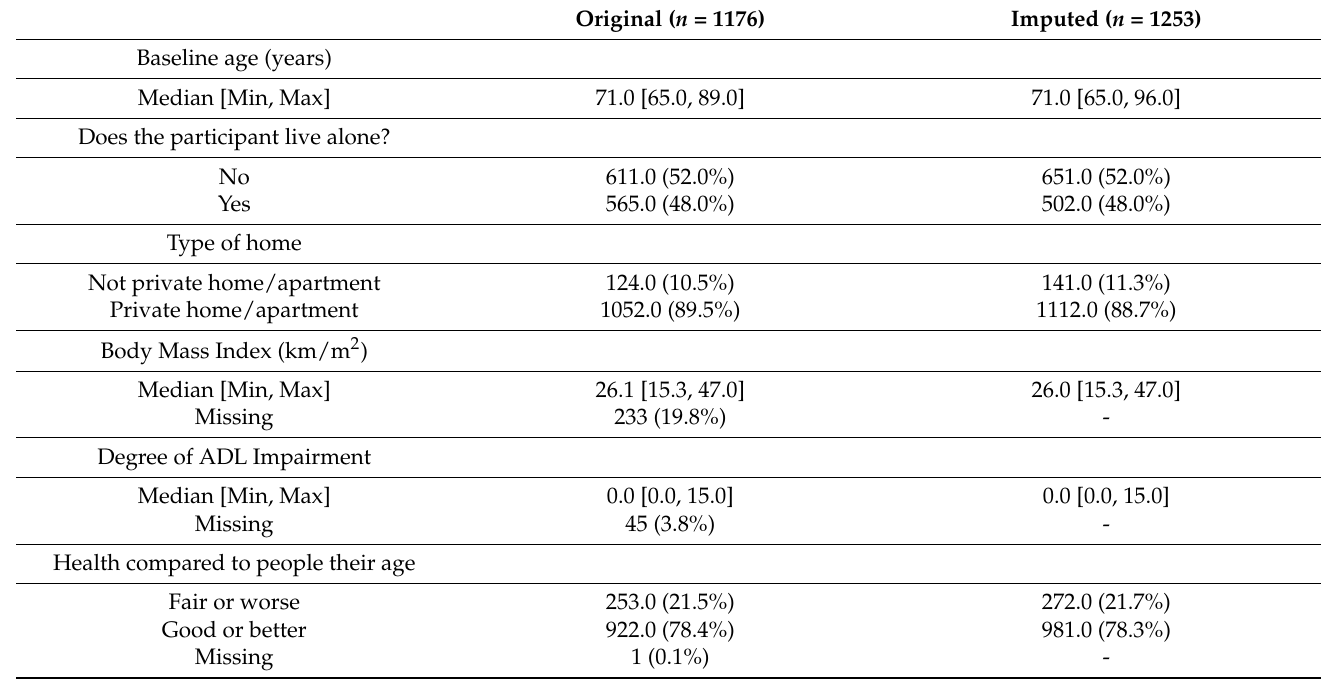
Table A7. Baseline characteristics of imputed data used for analysis vs. original